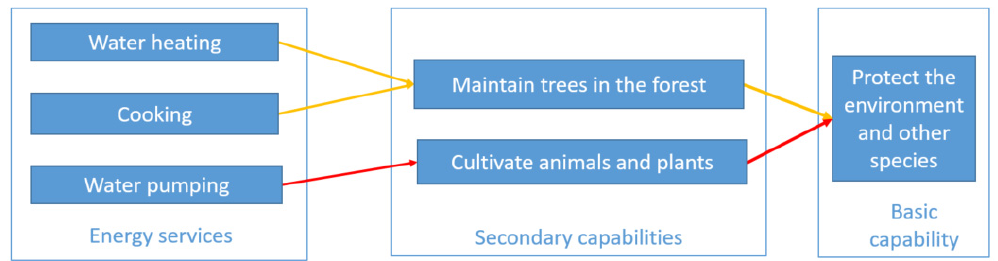
Figure 8. Relationships between energy services, secondary capabilities, and being able to live well towards other species.